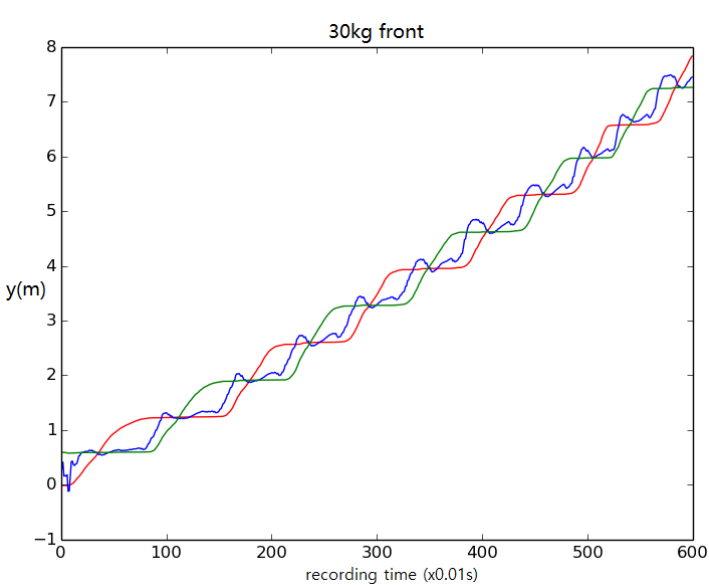
Figure 16. A simulated pack is added on the torso. Backpack on the left and front pack on the right.